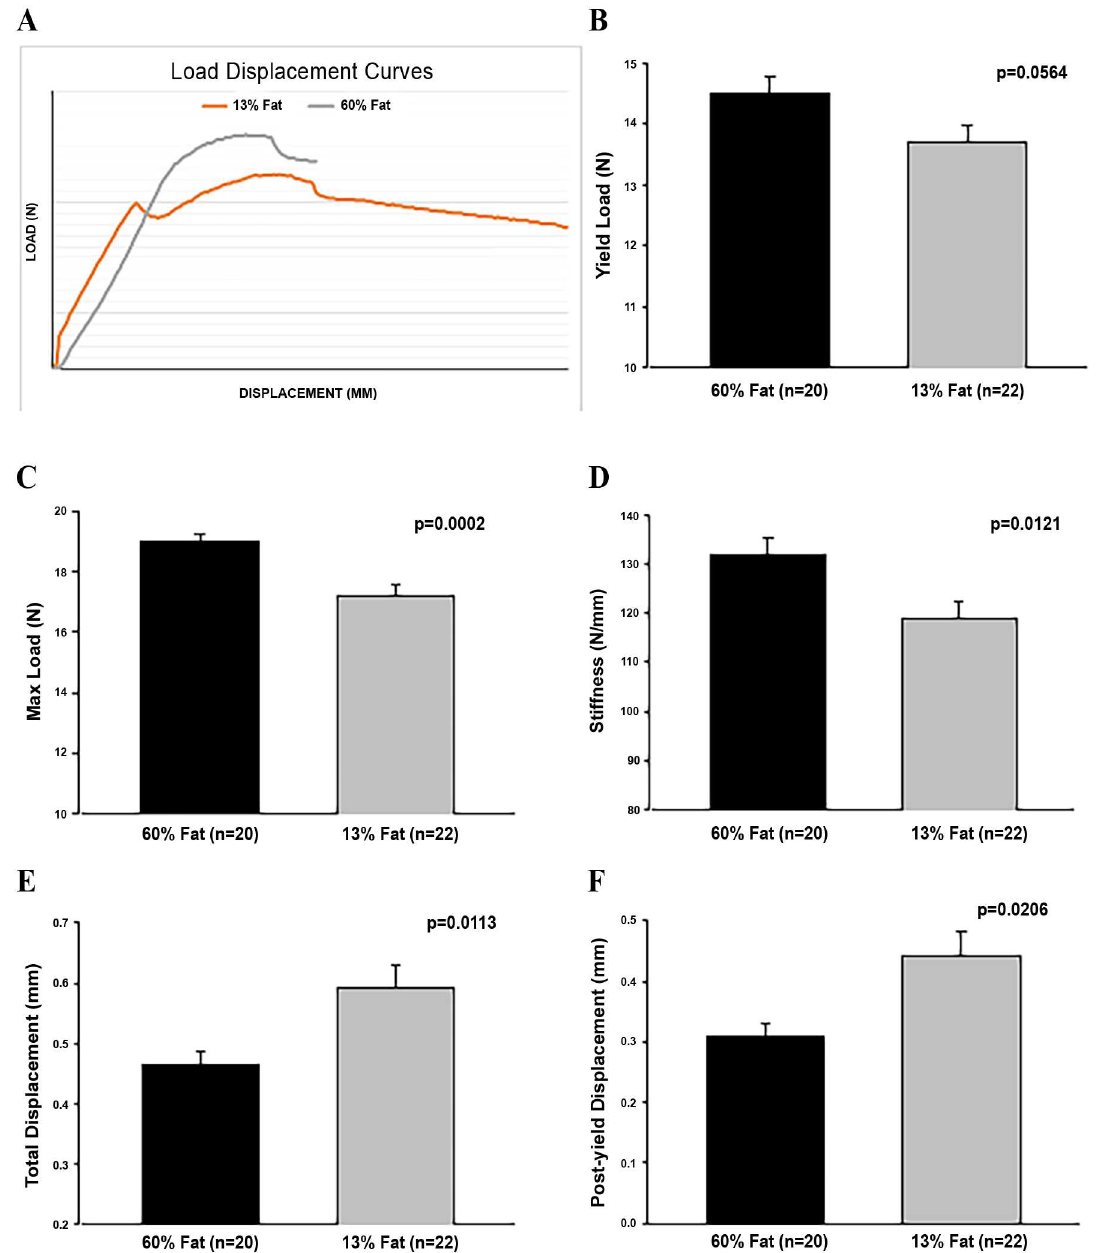
Fig 10. Bone measuresin high-fat versus control diets. Representative load-displacement curves of female mice fed the high-fat and control diets (A). Effects in female mice fed high-fat and control diets for yield load (B), max load (C), stiffness (D), total displacement (E), post-yielddisplacement(F). Values are means ± SE; p-values represent main effect of fat. Sample size is shown in parenthesis. Mice fed the high-fat diets had increasedfemoral biomechanical performance values for yield load, max load, and stiffness compared to mice fed the control diets. Mice fed the high-fat diets had reducedfemoral biomechanical performance values for total displacement and post-yielddisplacement compared to mice fed the control